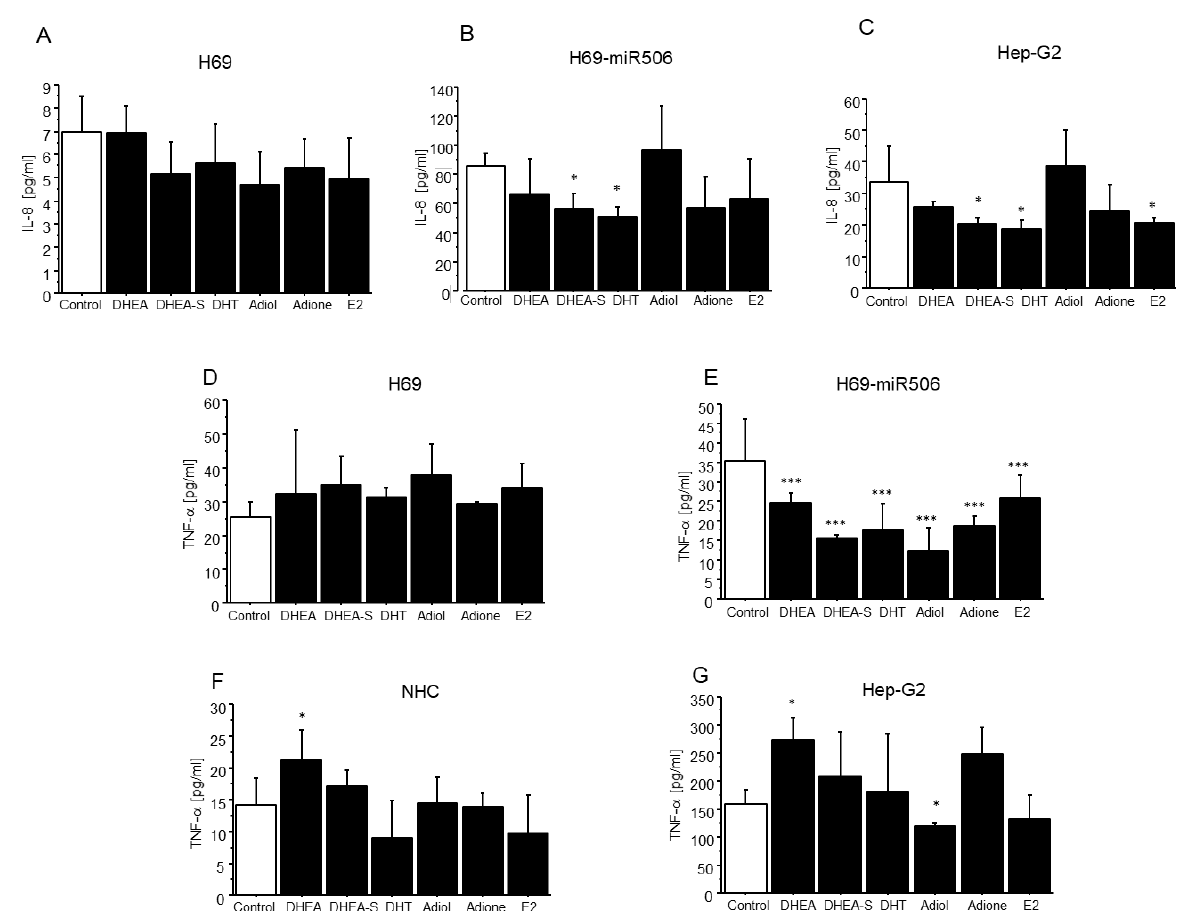
Figure 3. DHEA and its metabolites affect the IL-8 ( A – C ) and TNF- α ( D – G ) levels in cholangiocytes and hepatocytes. Cells were incubated with DHEA, DHEA-S, DHT, adiol, adione, and E2. After 24 h, the levels of IL-8 and TNF- α were measured using appropriate ELISA assays. Results are presented as mean ± SD ( n = 3); * p < 0.05, *** p < 0.001. 2.4. The Effect of DHEA and Its Metabolites on the Level of Pro-Fibrotic IL-13 Since IL-13 was correlated with enhanced fibrosis, we checked how DHEA and its metabolites influence the level of IL-13 in cholangiocytes and hepatocytes. We showed for the first time that DHEA-S significantly diminished the level of IL-13 in normal human cholangiocytes (H69 and NHC) ( p < 0.05; Figure 4A,C) and hepatocytes (Hep-G2) ( p < 0.05; Figure 4D). Moreover, DHT and adiol significantly reduced the level of IL-13 in normal human cholangiocytes (NHC) ( p < 0.05; Figure 4B). Neither DHEA nor its metabolites changed IL-13 levels in PBC-like human cholangiocytes (H69-miR506) (Figure 4D).In addition, our unpublished ELISA data revealed that the level of IL-13 was not significantly changed in sera of older female patients at an age of PBC diagnosis over 65 in comparison to younger patients. However, there was a significant negative correlation between IL-13 and both IL-1 β ( r = − 0.507, p = 0.003) and TNF- α ( r = − 0.390, p = 0.032) and positive correlation between IL-13 and E3 ( r = 0.572, p = 0.0007) in PBC patients at an age of diagnosis above 65 (see Table